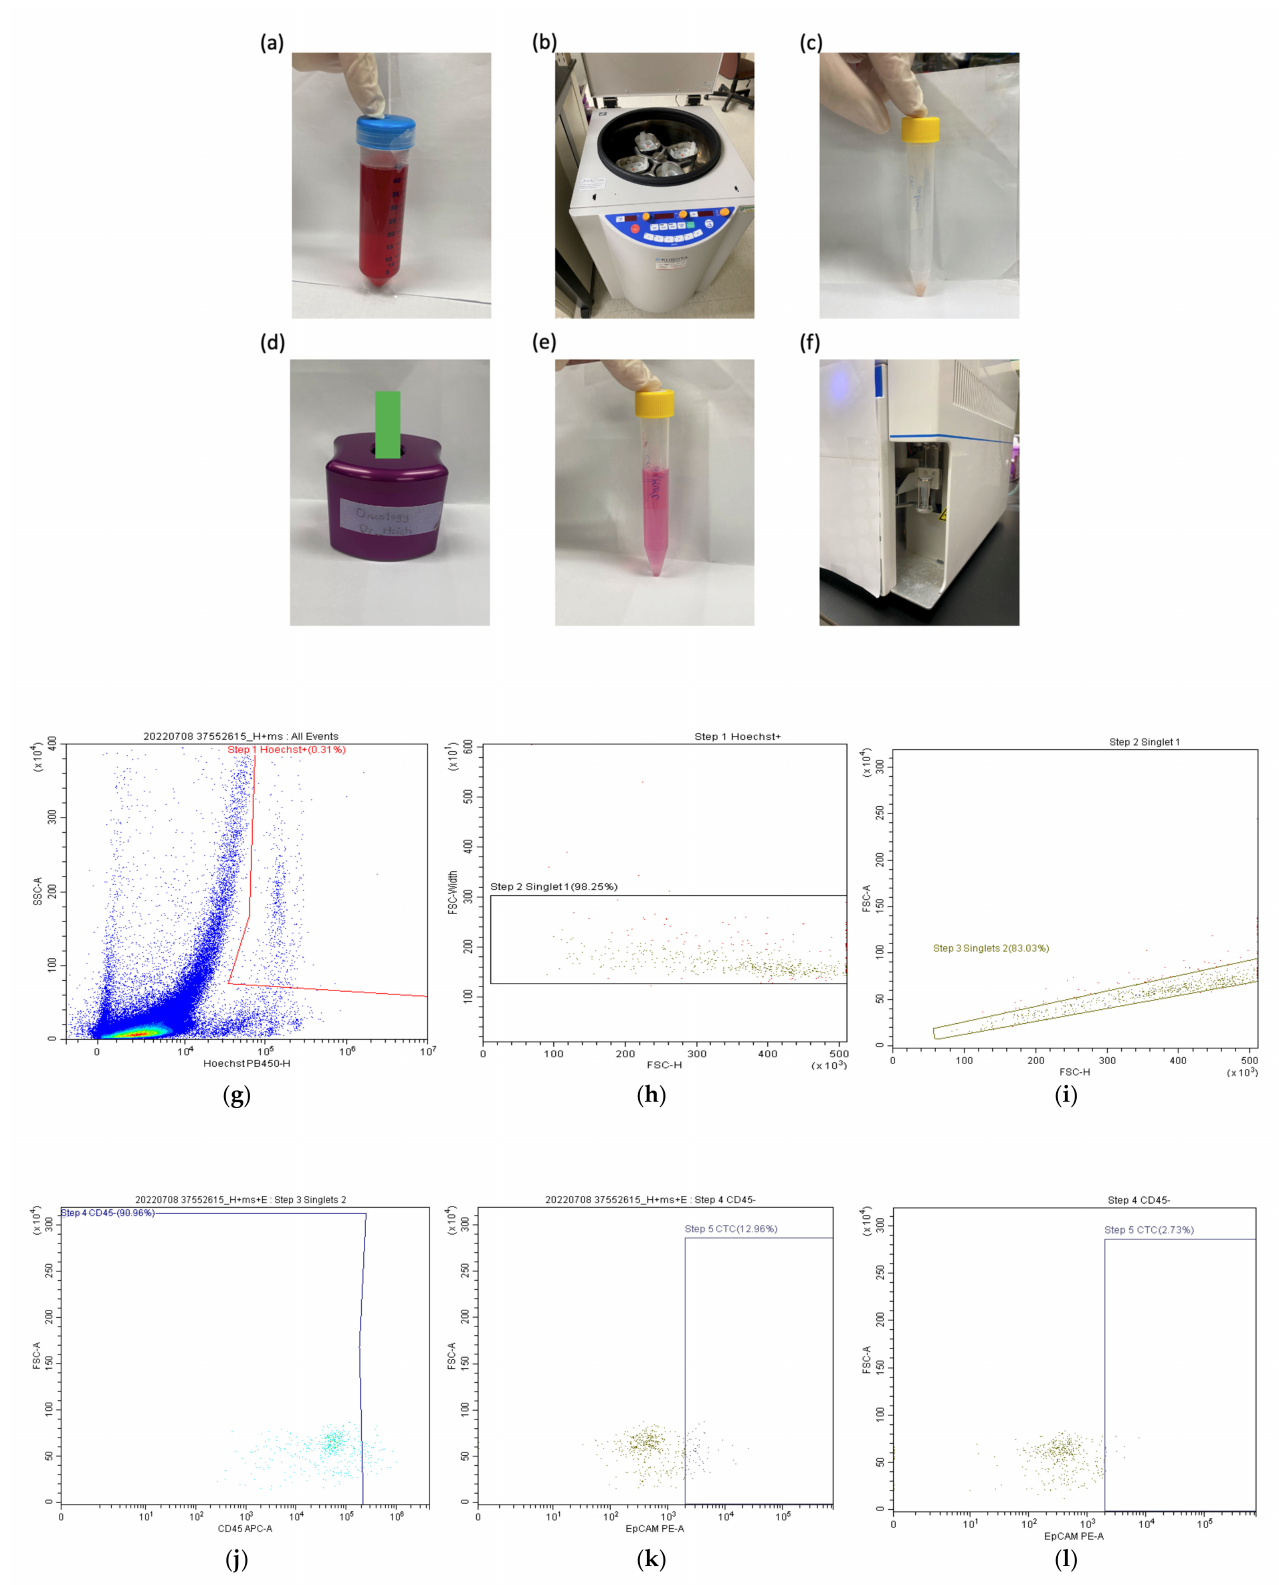
Figure 1. ( a – f ) Schematic representation of the procedure used to quantify circulating tumor